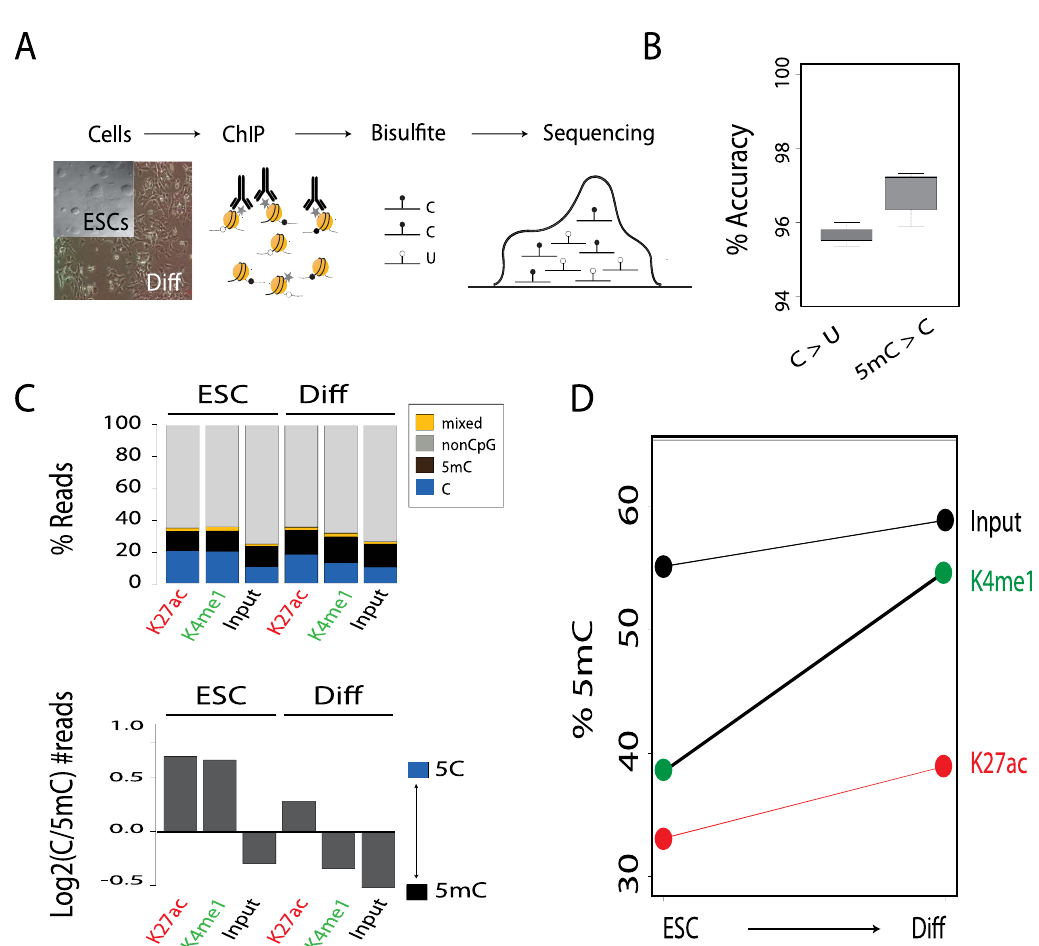
Fig 1. DNA methylation increases during differentiation. (A) Schematic representation of the ChIP-BS-seq-based analysis of mouse ESCs and differentiated cells (Diff). (B) Quality of BS-seq was analyzed by spiking in oligonucleotides with 5mC and 5C. Plotted is accuracy (%) for each nucleotide. (C) Upper panel: Bar plot of percentages of C, 5mC, mixed (in which adjacent CpGs had different methylation states), and non-CpG reads for ChIP experiments and input for ESCs and differentiated cells. Lower panel: Log2 fold change between C and 5mC reads for each condition. (D) Percentage of 5mC in ChIP experiments and input in ESCs and differentiated cells.